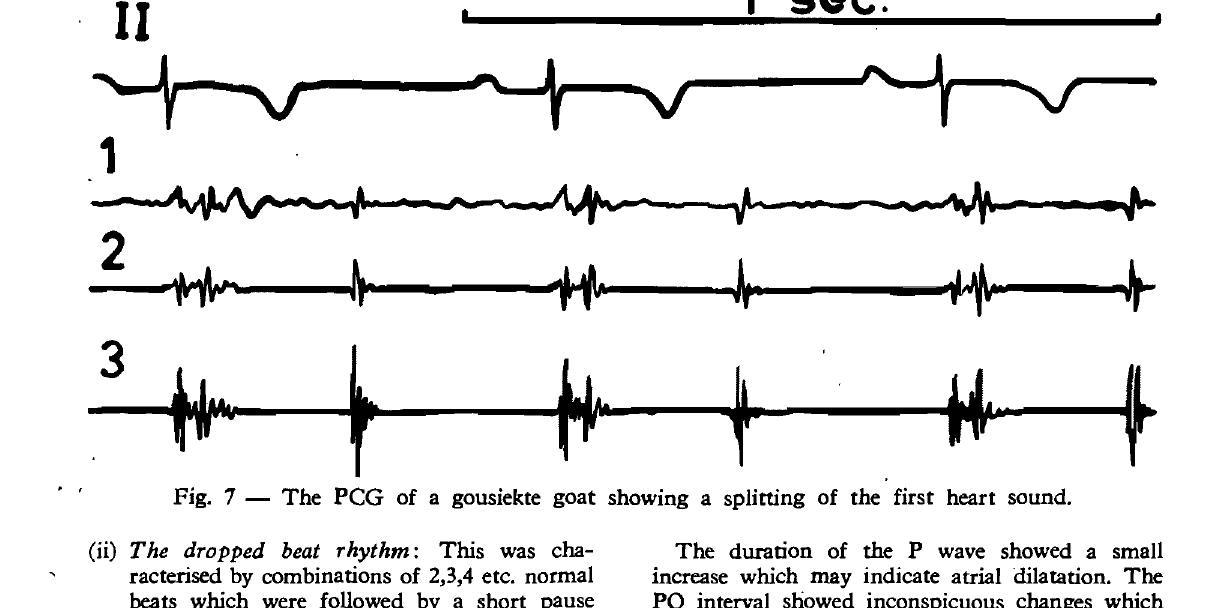
Fig. 7 - The PCG of a gousiekte goat showing a splitting of the first heart sound.